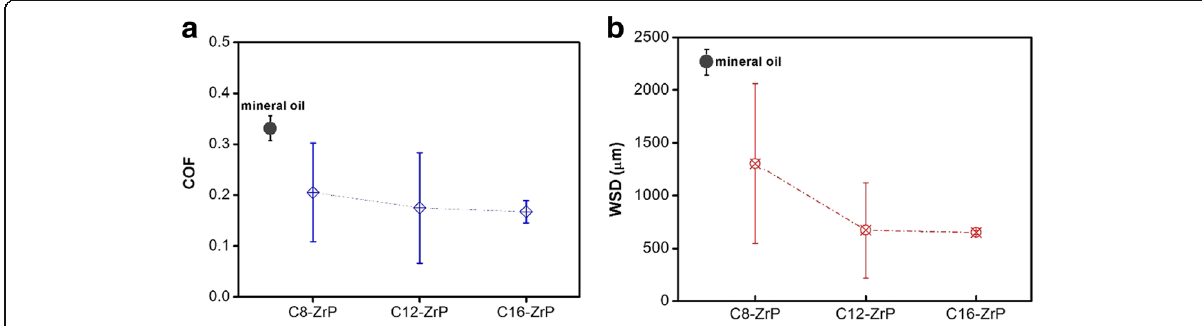
Fig. 5 a Friction coefficients and b wear scar diameters of surface-modified ZrP nanoplatelets